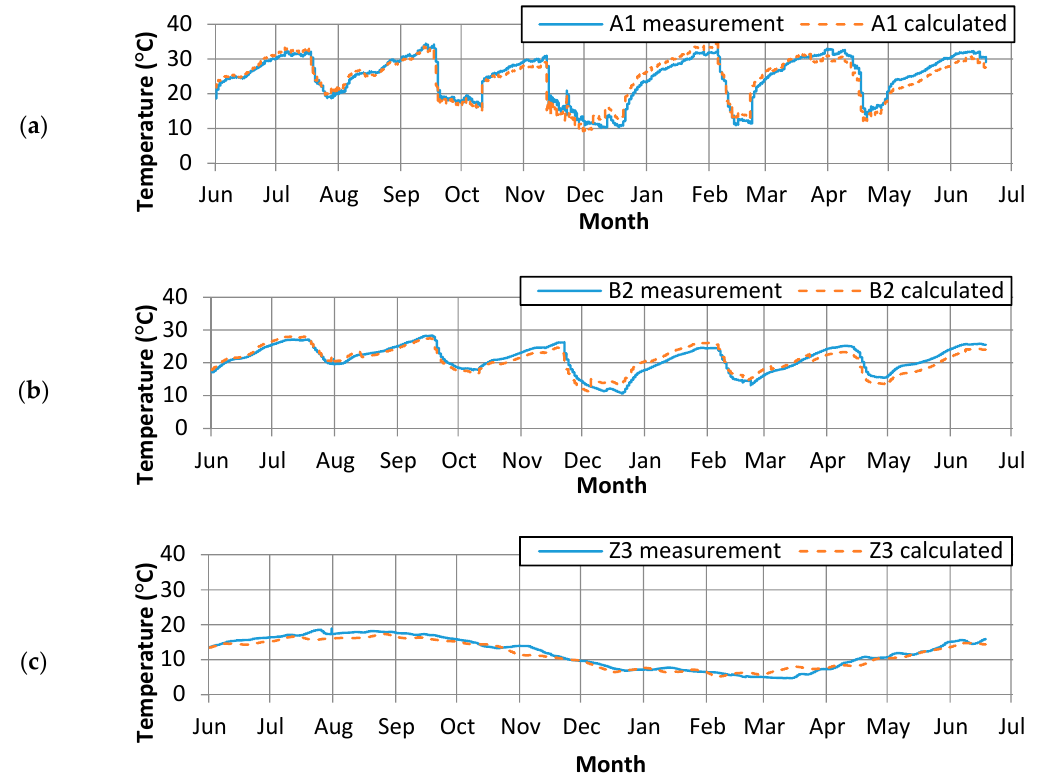
Figure 4. Measured and calculated temperatures in points: ( a ) A1; ( b ) B2; ( c ) Z3.